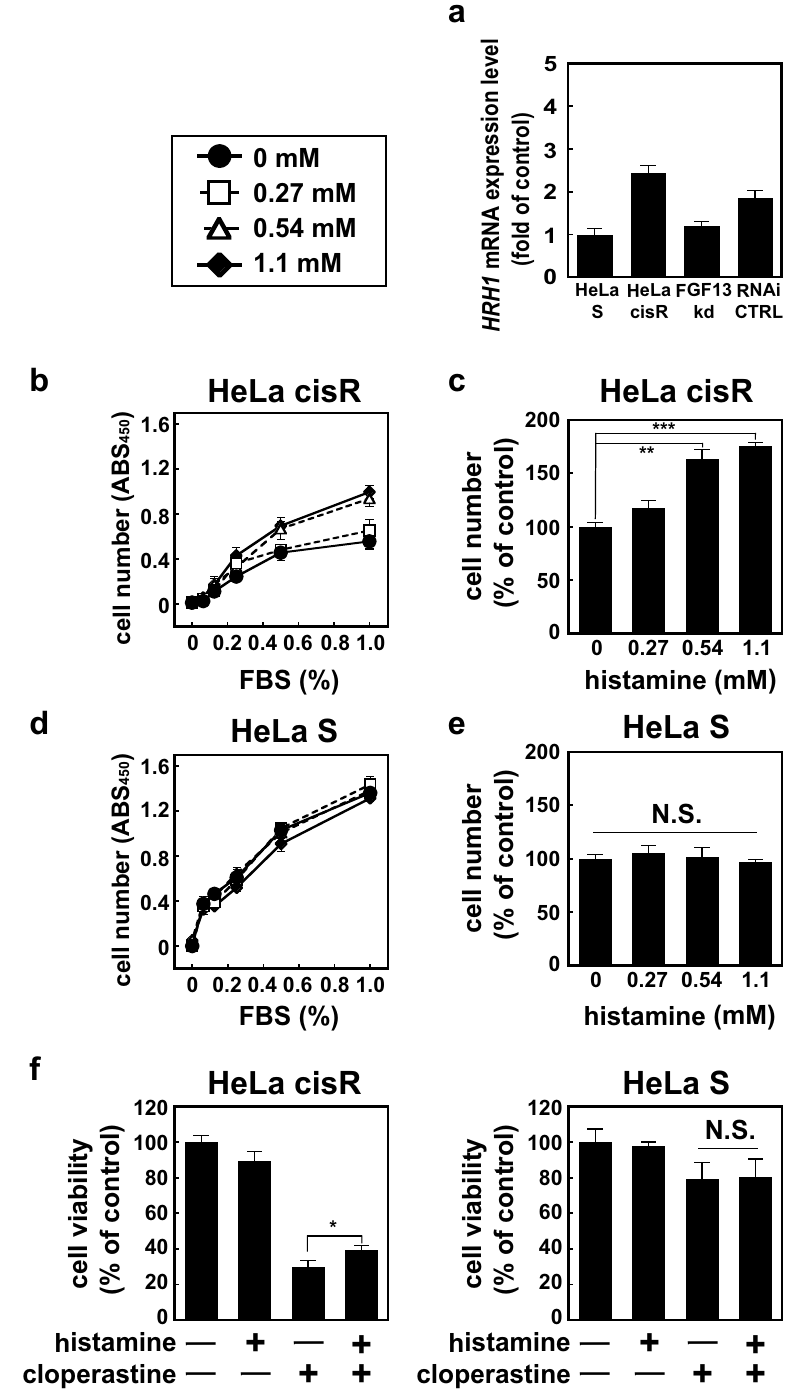
Figure 5. Expression of histamine H1 receptors is upregulated in HeLa cisR cells, and histamine enhances HeLa cisR cell proliferation. ( a ) Relative expression of histamine H1 receptor mRNA in HeLa S cells, HeLa cisR cells, FGF13kd cells, and HeLa cisR RNAi CTRL cells. ( b , d ) Effects of histamine on cell proliferation were examined in the culture media containing the indicated concentrations of FBS. Filled circles, 0 µg/ml; open squares, 50 µg/ml; open triangles, 100 µg/ml; filled diamonds, 200 µg/ml. ( c , e ) The data collected in the 1% FBS-containing medium in ( b , d ) are plotted to help comparison. ( f ) Effects of 500 µg/ml (2.7 mM) histamine on the viability of HeLa cisR and HeLa S cells in the absence or presence of 120 µM cloperastine. In this experiment, attached cells in the 10% FBS-containing medium were first treated with histamine for 1 day and then incubated in the absence or presence of cloperastine for 2 days, after which cell viability was measured as described in the methods. The results are presented as means ± S.D. of triplicate ( a ), quadruplicate ( b – d ), or sextuplicate ( f ) samples. Three separate experiments yielded essentially the same results. The significance of the difference between the selected pairs of results was determined with ANOVA (***p < 0.001; **p < 0.01; *p < 0.05; N.S., not